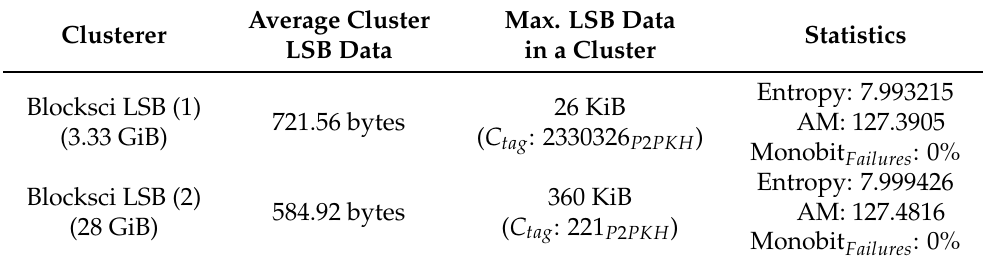
Table 5. Summary of the results of the clustering